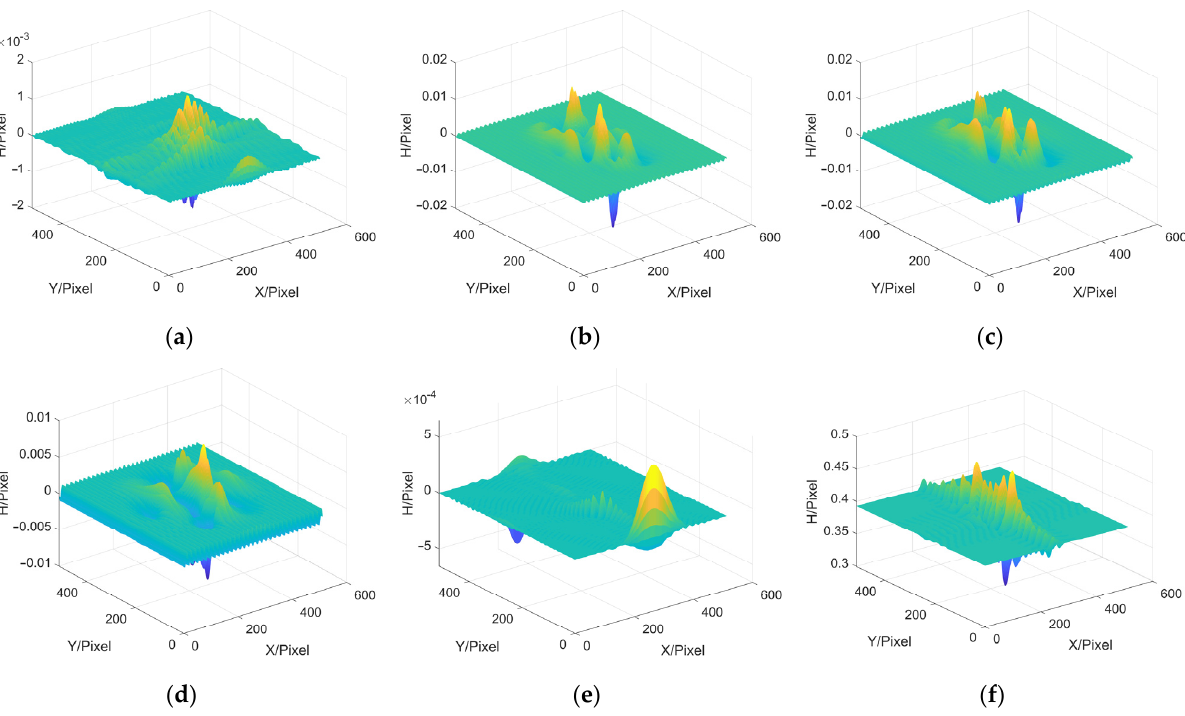
Table 1. Comparison of experimental results.